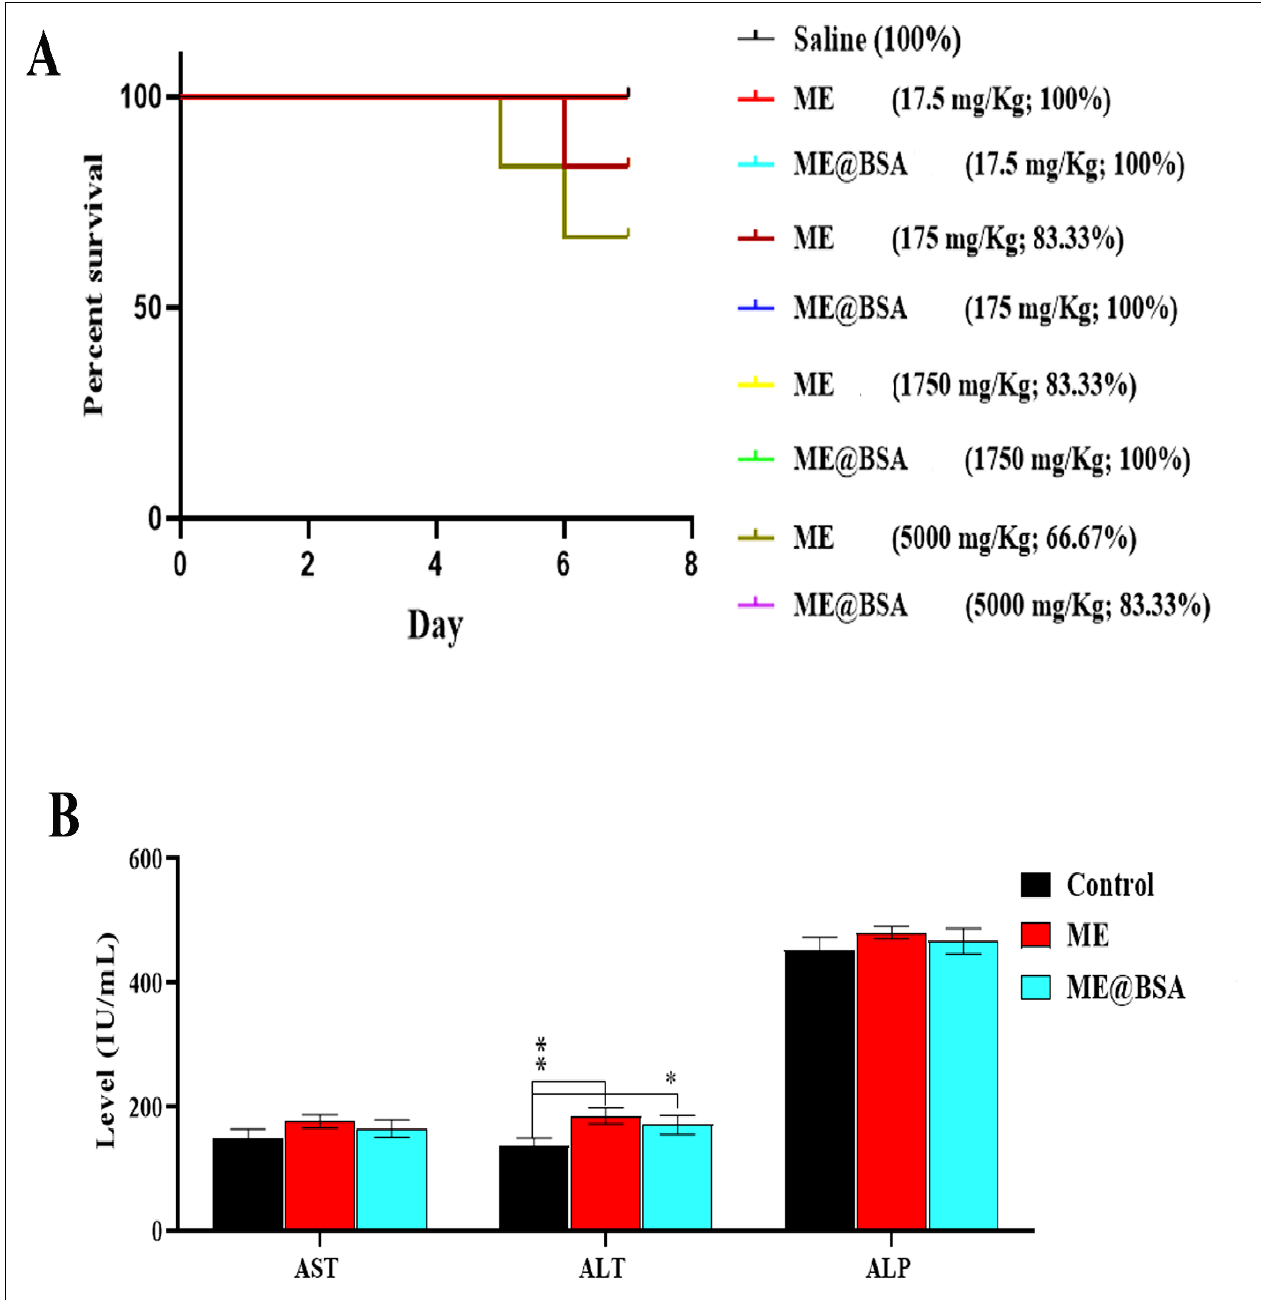
Figure 7. ( A ) Determination of LD 50 by administering increasing doses of ME@BSA, ( B ) Determi- nation of the effect of ME and ME@BSA on the levels of AST, ALT, and ALP enzymes. * p < 0.05, and ** p < 0.01 were considered as significant.